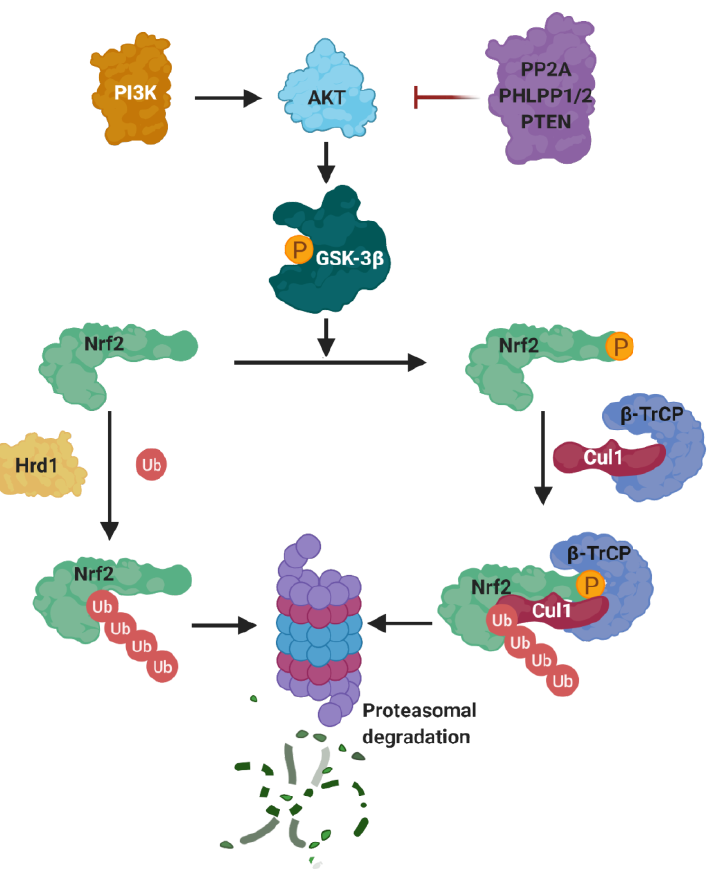
Figure 14. KEAP1-independent negative regulation of NRF2. The latter protein is tightly regulated by different systems, independently of its principal repressor KEAP1, to ensure the activation of the phase II response only under stress conditions. From left, the activation of different pathways might lead to PI3K activation that activates AKT by phosphorylation that in turn, from right, was inhibited by protein phosphatase 2A (PP2A), PHLPP1/2 (PH domain and leucine rich repeat protein phosphatases 1 and 2), or tumor suppressor phosphatase and tensin homolog (PTEN). After its activation, AKT is able to phosphorylate GSK-3β at Ser 9 inhibiting its activity reducing the negative regulation of NRF2 by this kinase. GSK-3β is known to act as a negative NRF2 regulator by several mechanisms. NRF2 can be phosphorylated by this kinase at Ser335 and S338 to create a phosphodegron domain DSGIS recognized by β-TrCP that leads to Cul1/Rbx1 NRF2 ubiquination and proteasomal degradation. NRF2 is also regulated by a third ubiquitination-degradation system by interaction with Hrd1, at the Neh4 transactivation